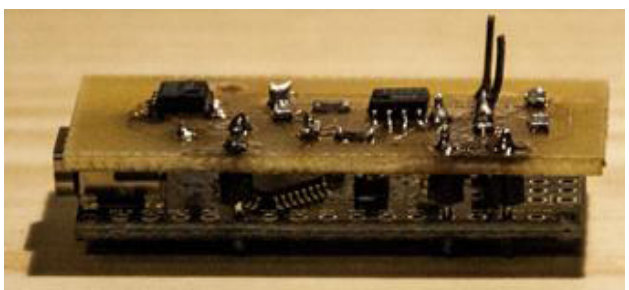
Figure 8. ArcAid processing cycle.